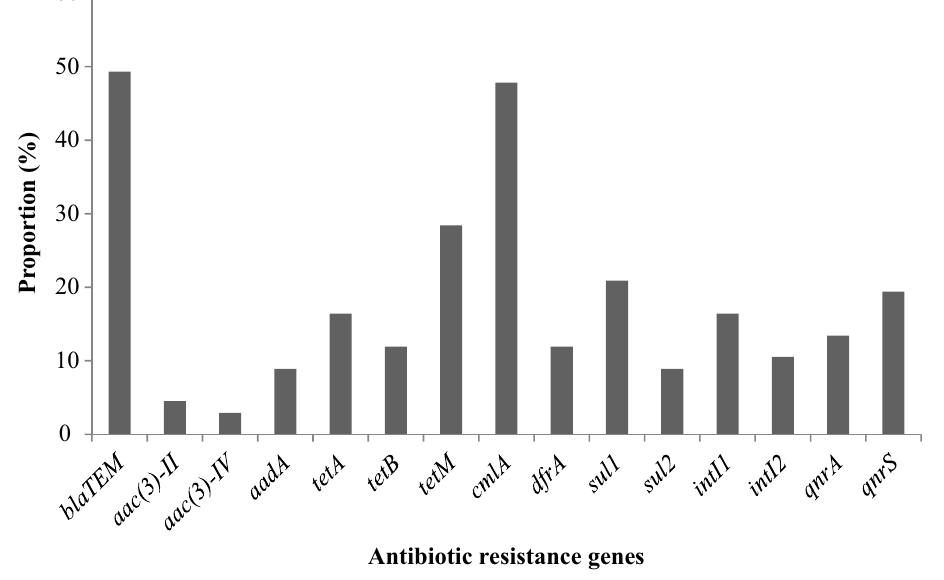
Figure 1. The proportion of antibiotic resistance genes distribution pattern of V. parahaemolyticus